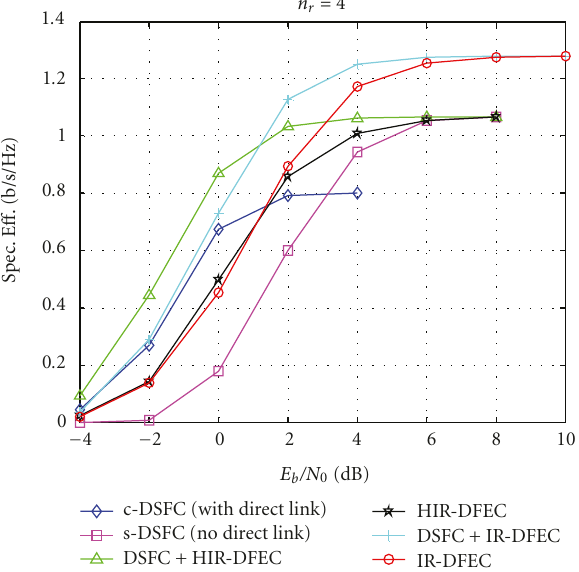
Figure 9: Spectral e ffi ciency versus E b /N 0-direct —scenario D1— n d = n r = 2.